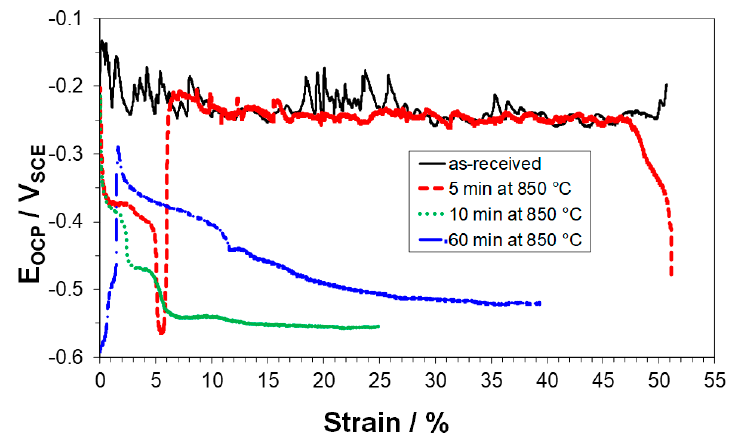
Figure 13. E OCP —strain curves obtained with SSRT performed in NACE TM-0177 in the presence of 10 − 3 M S 2 O 32 − on DSS 2304, both as-received and aged at 850 °C for 5, 10 and 60 min.